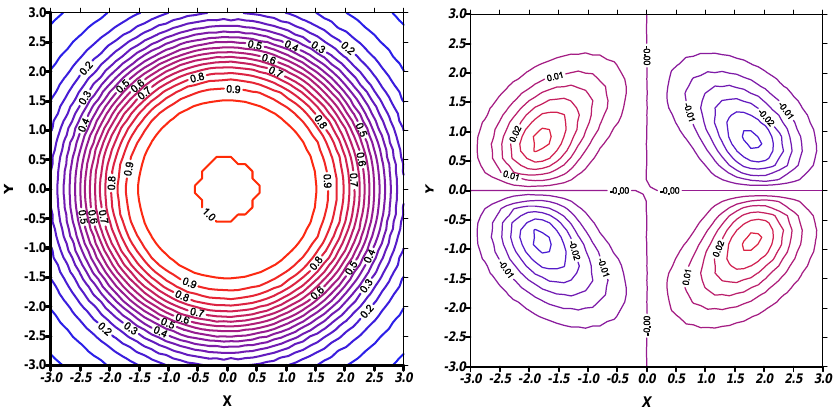
FIG. 6. (Color) Wider electron beam (left) and its distortion (right).